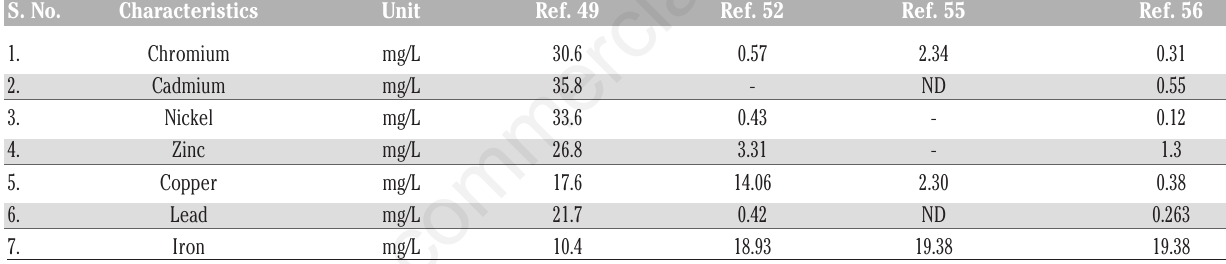
Table 5. Concentrations of heavy metals in pharmaceutical industrial effluents. S.